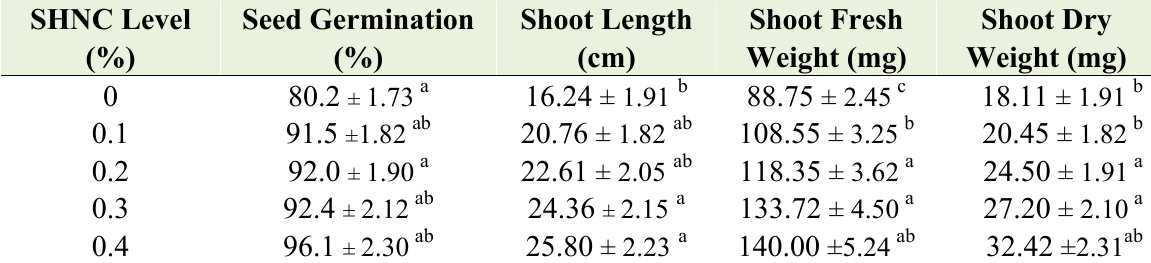
Different superscript letters indicate significant difference at p = 0.05. Mean with same alphabets with in the same column indicate non significant ( p > 0.05) differences among SHNC